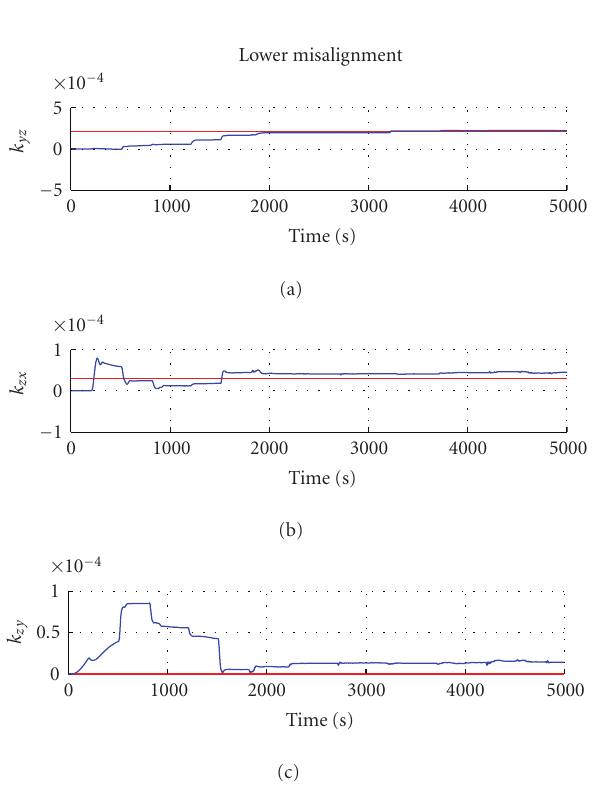
Figure 14: Lower misalignment error estimation.